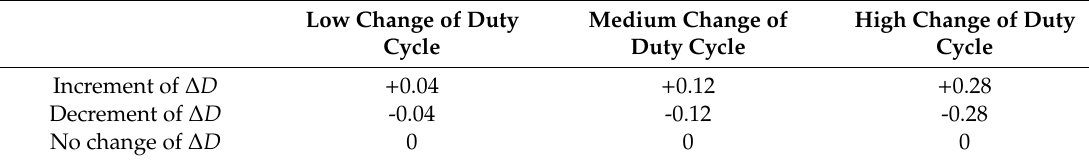
Table 3. Action-space of the proposed Q-learning-based GMPPT method.